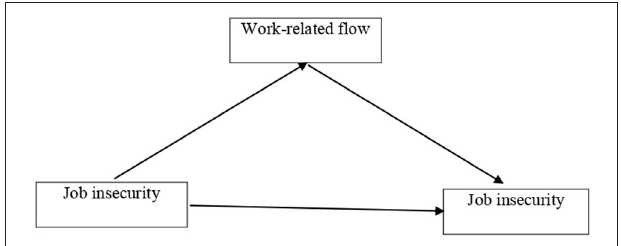
FIGURE 1 | Conceptual model. Covariates: gender, age, marital status, income, SRH, and COVID infection